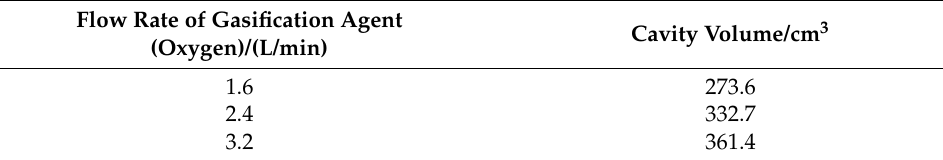
Figure 12. Multiple fields in a single cavity generation process. Table 1. Relationship between flow rate of gasification agent and final cavity volume.